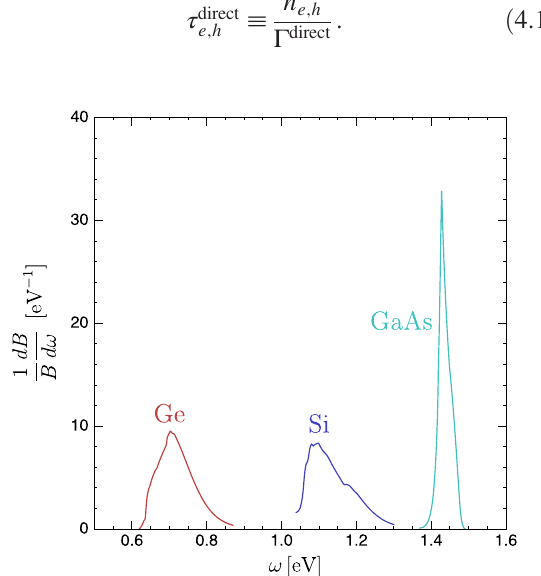
FIG. 13. Normalized spectrum of photons ð dB=d ω Þ =B emitted by the recombination of e − h þ pairs in Ge, Si, and GaAs, obtained using Eq. (4.9) and the radiative absorption coefficients pre- sented in Refs. [125 – 127]. We assume zero doping and room